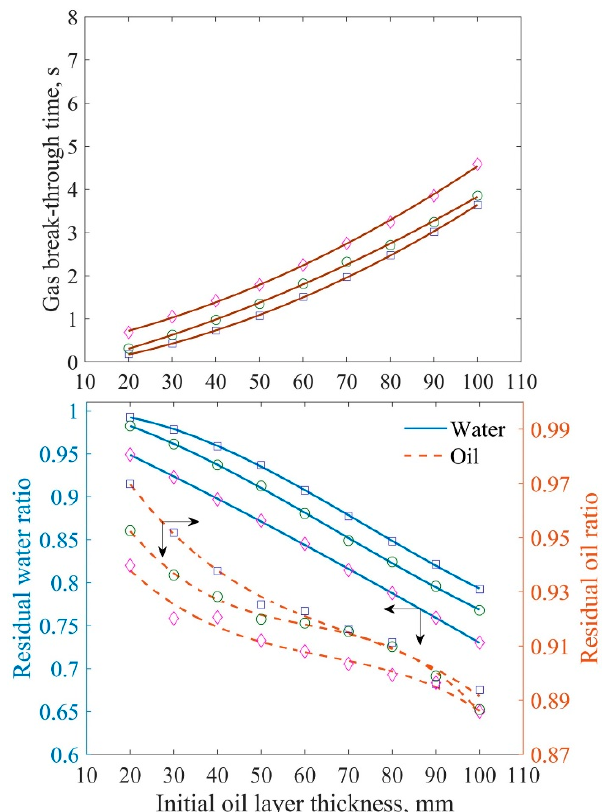
Figure 7. Upper panel: Effect of initial oil layer thickness on gas breakthrough time at different initial l–l interface levels. Lower panel: Effect of initial oil layer thickness on residual ratios of both liquids at different initial l–l interface levels. Pressure difference: 0.3 bar, oil viscosity: 0.131 Pa · s, initial l–l interface levels: 5 mm (marked by squares), 10 mm (marked by circles), and 20 mm (marked by diamonds).